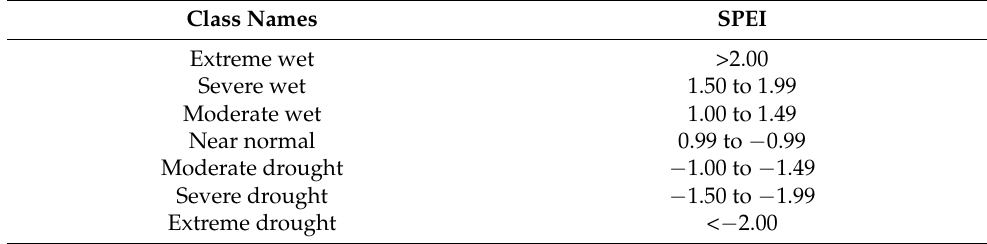
Table 1. Drought categories for the values of SPEI following the criteria of Stagge [67]. Class Names SPEI Extreme wet